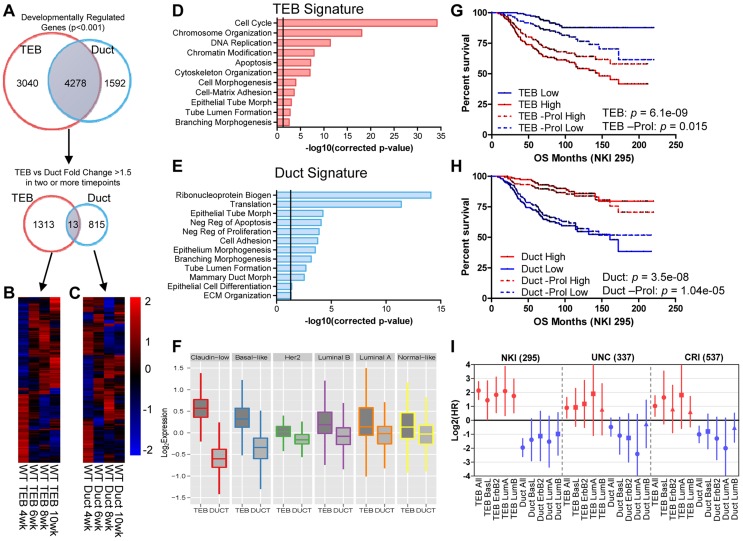
Developmental TEB and duct gene signatures derived from time course expression profiling predict breast cancer prognosis.(A) Identification of developmentally regulated genes with the BETR algorithm in TEB and duct cells over the time course of branching morphogenesis (4, 6, 8, and 10 weeks). TEB and duct signatures were further refined to by selecting genes with at least 1.5-fold expression change in at least two time points for each cell type. (B–C) Heat map of resulting (B) 1,313 TEB and (C) 815 duct gene signatures expressed at least 1.5-fold or greater in their respective cell type in at least two time points. (D–E) Biological processes associated with (D) TEB and (E) duct gene signatures. The TEB and duct signatures represent a proliferation and differentiation signature, respectively. Vertical line represents p-value at 0.05. (F) TEB and Duct signatures are differentially expressed in the molecular breast cancer subtypes. The TEB and duct signatures are more highly expressed in the poorly- and well-differentiated breast cancer subtypes, respectively. (G–H) Analysis of overall survival (OS) in NKI 295 cohort of patients classified into (G) TEB and (H) duct high and low expression groups based on median expression the respective gene signature, including the effects of removing proliferation genes (-Prol). High expression of the proliferative TEB signature confers poor prognosis, while high expression of the differentiated duct signature confers improved prognosis. P-value derived from Log-rank test. (I) Hazard ratios (HR) derived from overall survival analysis for TEB and duct signatures in the molecular subtypes of breast cancer in three separate data sets demonstrate similar trends observed in G–H. Red samples represent TEB signature and blue samples represent duct. Error bars represent 95% confidence interval; filled circles represent p-value<0.1, squares represent trends with p-value<0.25, and triangles represent non-significant changes with p-value>0.25.